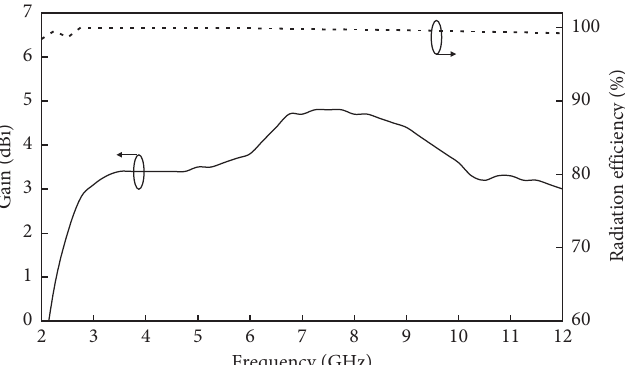
Figure 11: Gain and radiation efficiency versus frequency of the antenna.